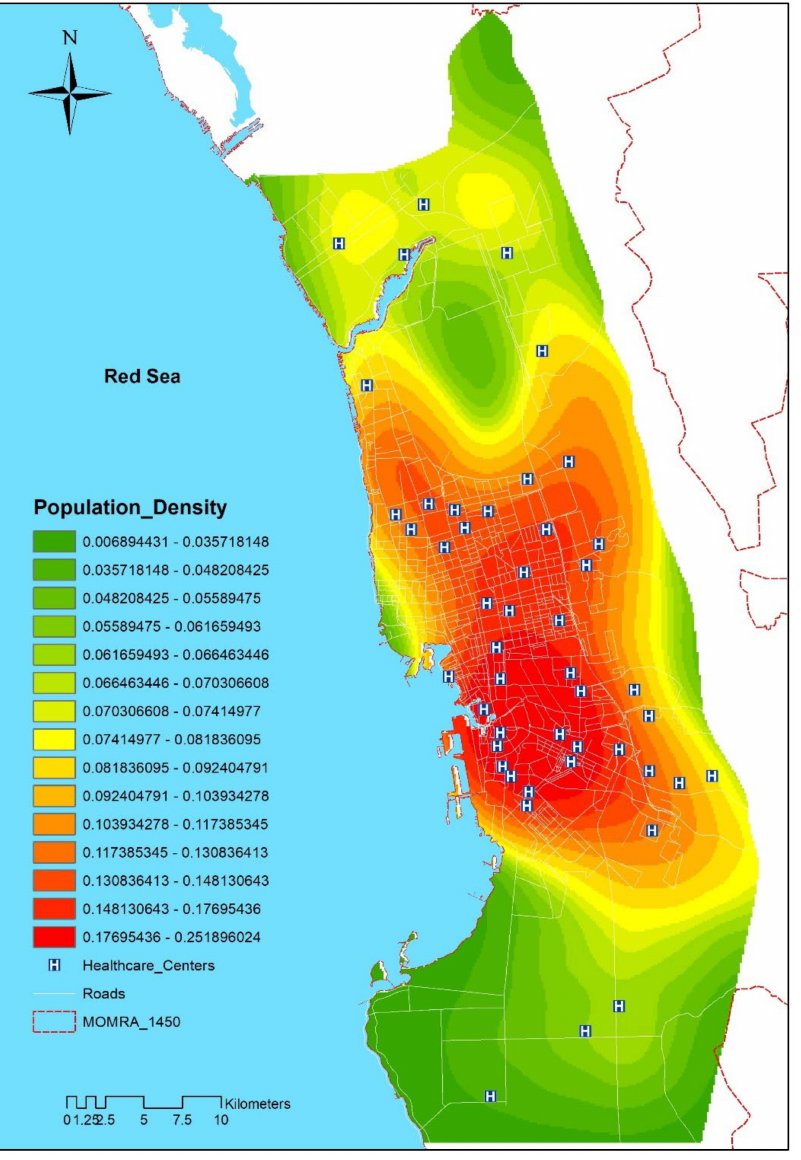
Figure 2. Spatial distribution of healthcare centers and population density. Note: population density classified by Kernel Density Model within the ArcGIS